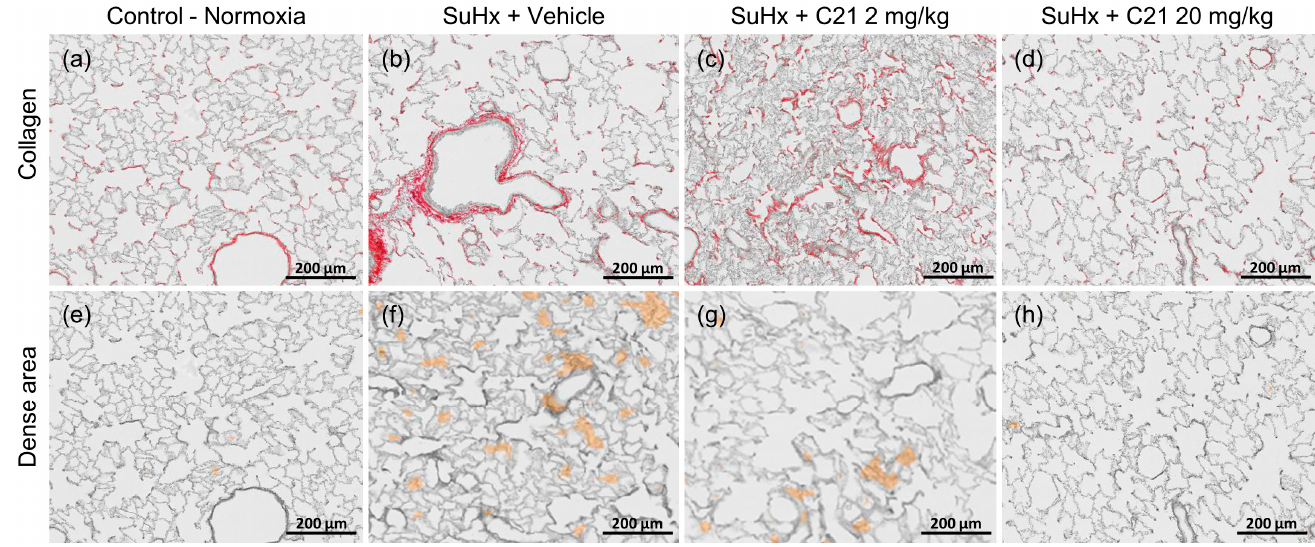
Figure 4. Representative images for fi brosis and collagen deposition and dense area in the lung of rats exposed to SuHx and C21. Areas with collagen deposition identi fi ed by picrosirius red staining rats exposed to SuHx and C21. Areas with collagen deposition identified by picrosirius red staining ( a – d ). Dense areas containing fi broblasts, myo fi broblasts, and newly formed collagen were identi- ( a – d ). Dense areas containing fibroblasts, myofibroblasts, and newly formed collagen were identified fi ed by automated morphometric analysis ( e – h ). by automated morphometric analysis ( e – h